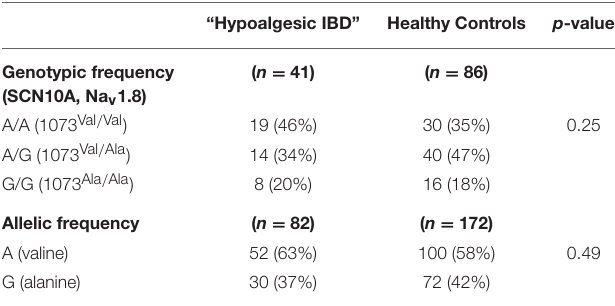
TABLE 5 | Genotypic and allelic frequencies of the SCN10A polymorphism, rs6795970 in Hypoalgesic IBD vs. Healthy Control patients. “Hypoalgesic IBD” Healthy Controls p